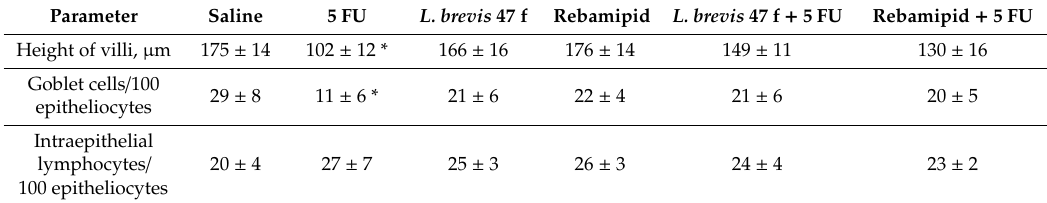
Figure 2. L. brevis 47 f prevents 5 FU-induced mucositis. ( a , c , e ): intestinal mucosa; ( b , d , f ), colon mucosa. ( a , b ): saline; ( c , d ): 5 FU 100 mg / kg daily × 3 days; ( e , f ): pretreatment with L. brevis 47 f followed by 5 FU. See Materials and Methods for details. Hematoxylin and eosin (H&E) staining. Initial magnification × 400. Table 2. Morphological parameters of intestinal mucosa in mice exposed to 5 FU with or without L. brevis 47 f or